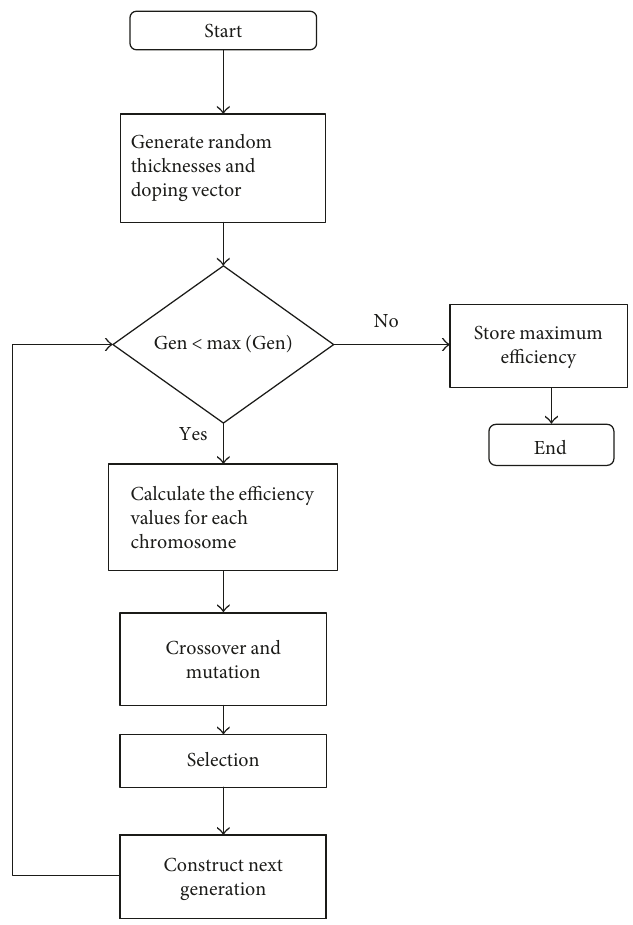
Figure 3: Flowchart of genetic